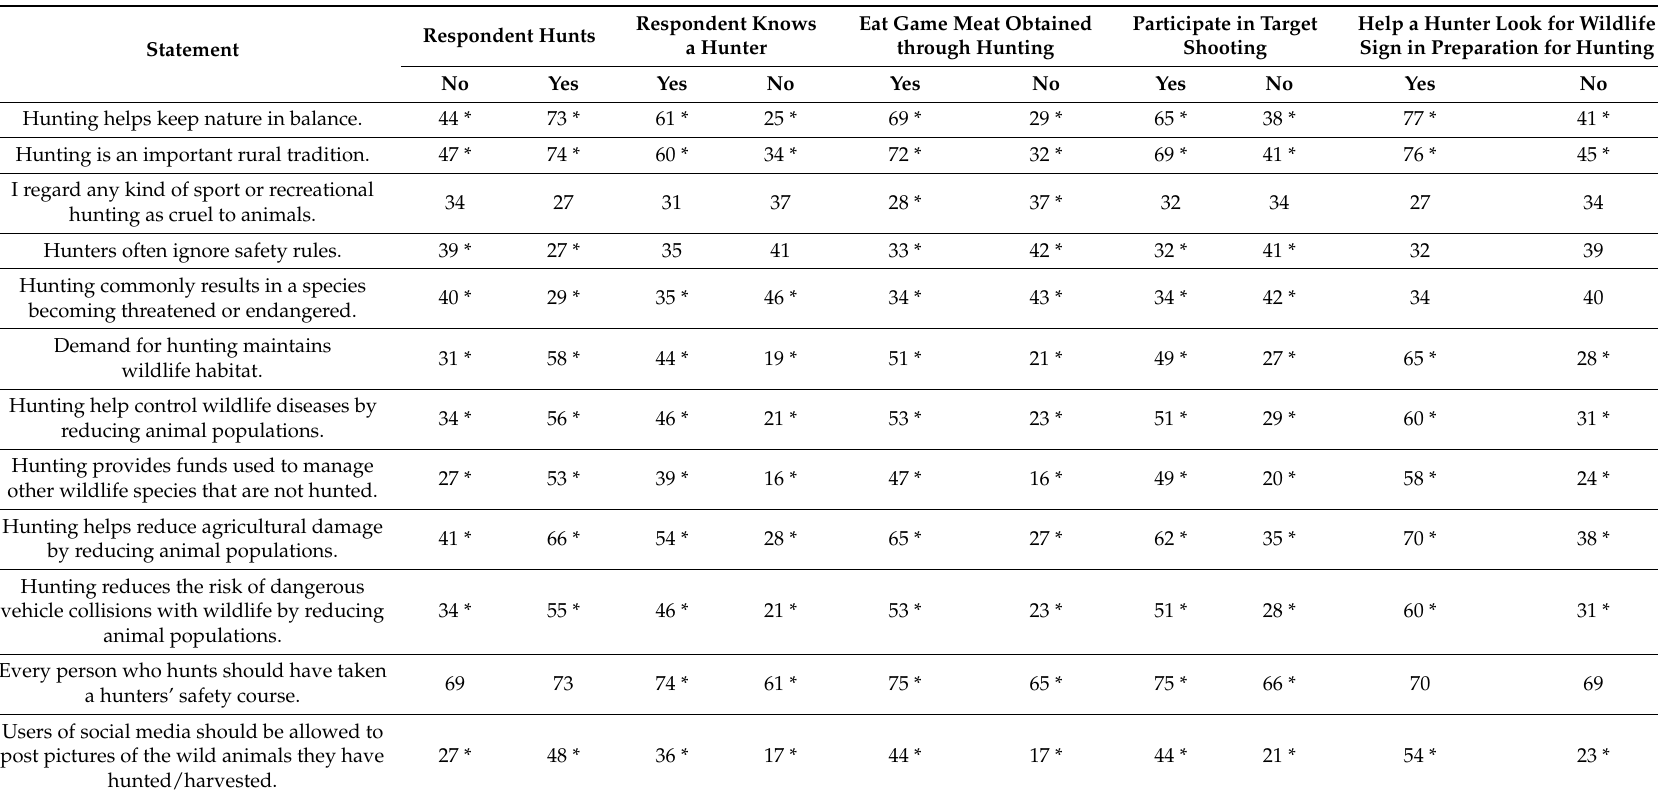
Table 2. Presentation of statistically significant differences in agreement with statements about hunting and participation in hunting-related activities ( α = 0.05 denoted by